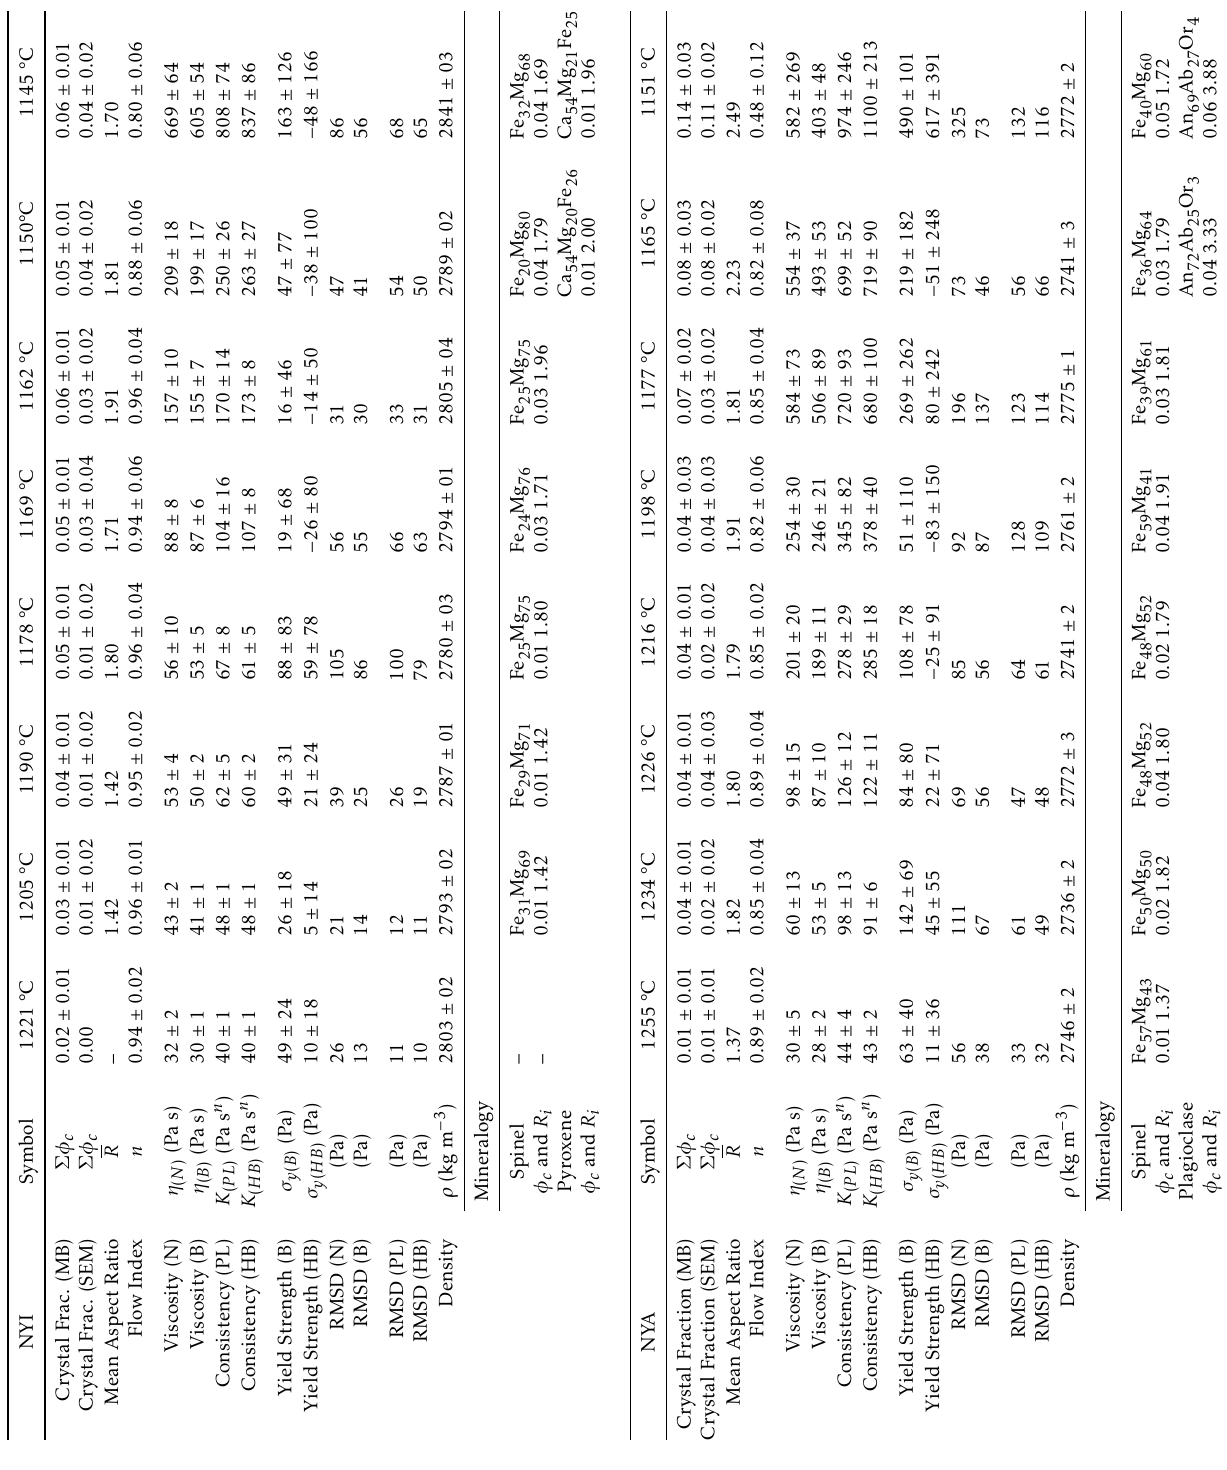
Table 2 – Crystal fractions, crystal aspect ratios, rheological parameters, densities, and mineralogy for each NYI- 2002 and NYA-1948 subliquidus experiment. Viscosity and consistency are provided for Newtonian (N), Bing- ham (B), power-law (PL), and Herschel-Bulkley (HB) fits. Yield strengths are given for appropriate fits. Crystal fractions were determined from mass balance (MB) and BSE images (SEM). Uncertainties are taken as 2 σ